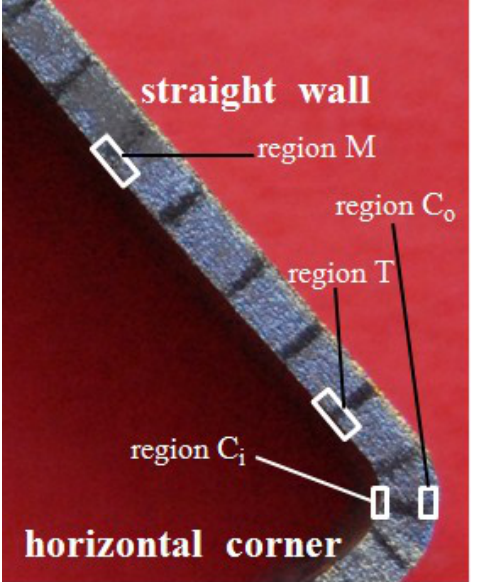
Figure 13. Regions for electron back scattering diffraction (EBSD) analysis.